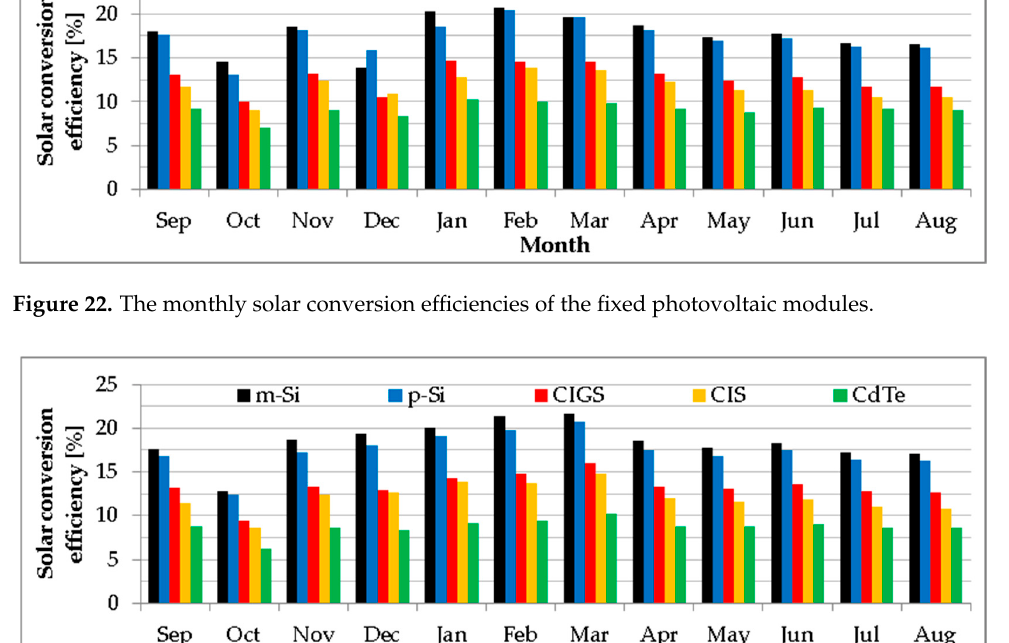
Figure 23. The monthly solar conversion efficiencies of the tracked photovoltaic modules.